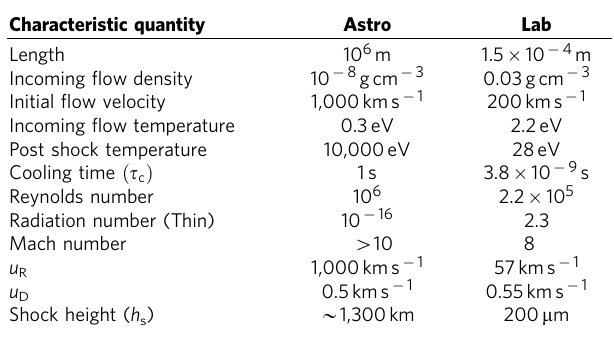
Table 1 | Scaling between the laboratory and the astrophysical